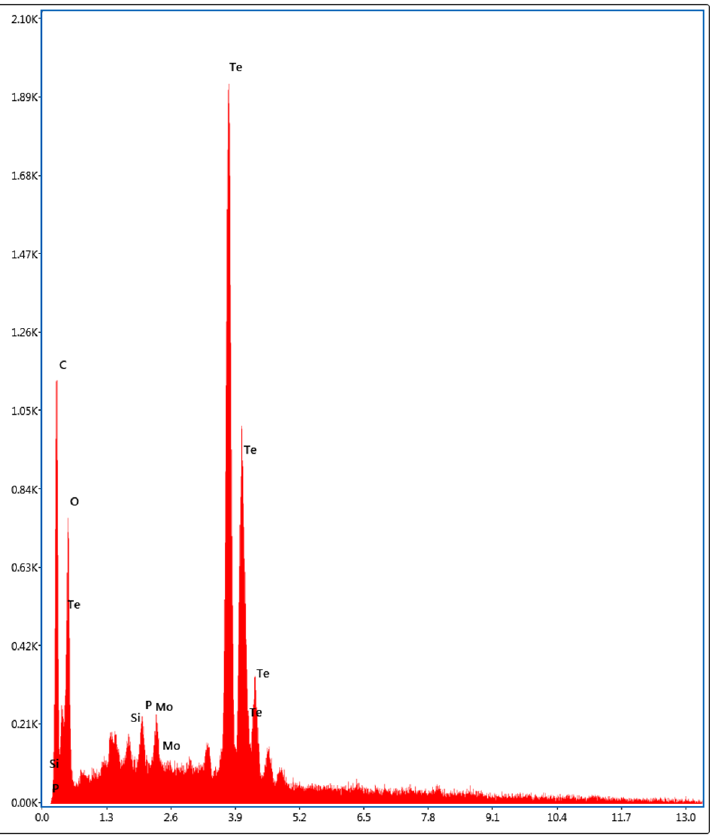
Figure 5. EDX spectrum of the biogenic TeNPs produced by Gayadomonas sp. TNPM15.